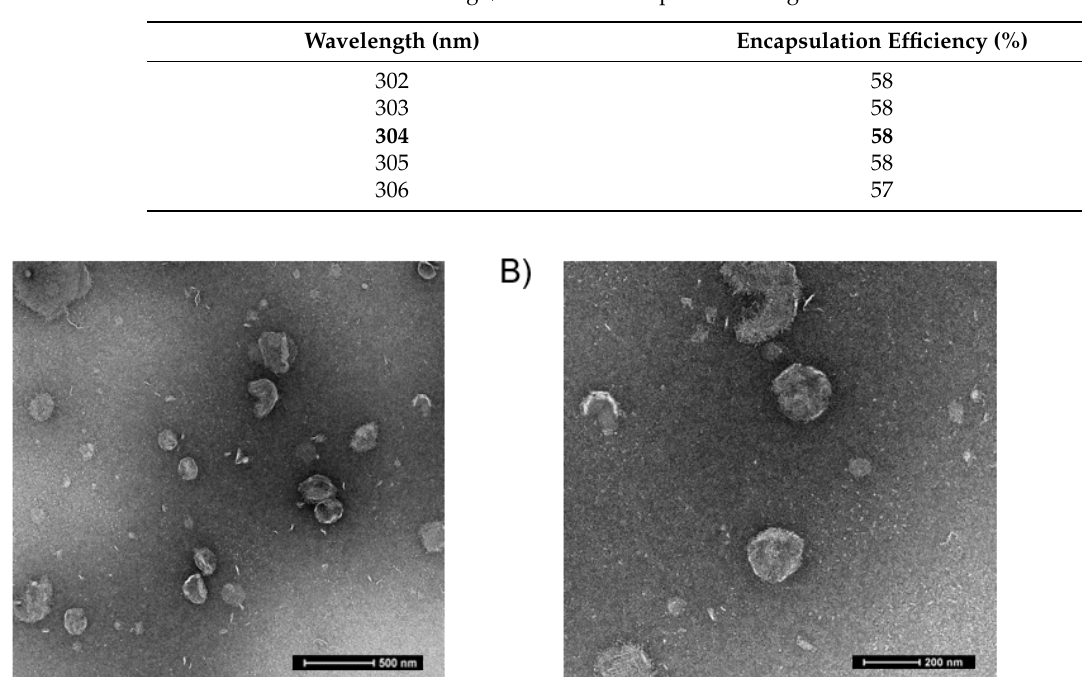
Figure 2. Representative transmission electron micrographs (TEM) of the liposomes. TEMs of the liposomes stained with uranyl acetate. ( A ) Representative TEM (lower magnification) demonstrating round shape and size with scale of 500 nm. ( B ) Representative TEM (higher magnification) demonstrating round shape and size with scale of 200 nm. The liposomes are roughly 250 nm in size, confirmed by dynamic light scattering.